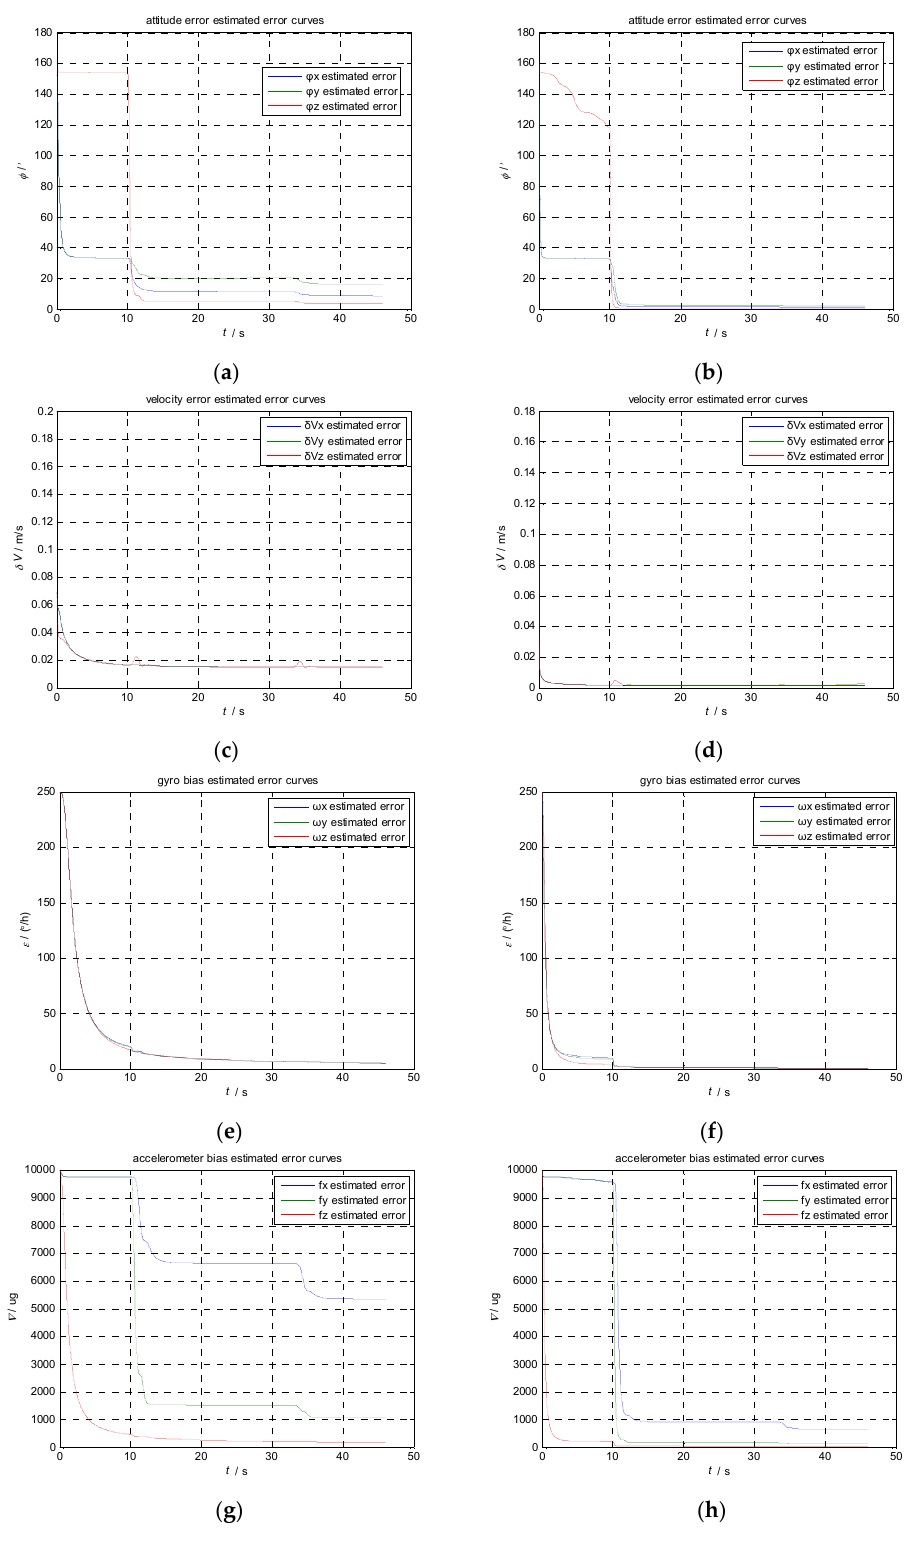
Figure 5 . Comparison of estimation error result using KF and AIKF. ( a ) Estimation error of attitude error using KF; ( b ) Estimation error of attitude error using AIKF; ( c ) Estimation error of velocity error using KF; ( d ) Estimation error of velocity error using AIKF; ( e ) Estimation error of gyroscope bias using KF; ( f ) Estimation error of gyroscope bias using AIKF; ( g ) Estimation error of accelerometer bias using KF; ( h ) Estimation error of accelerometer bias using AIKF.